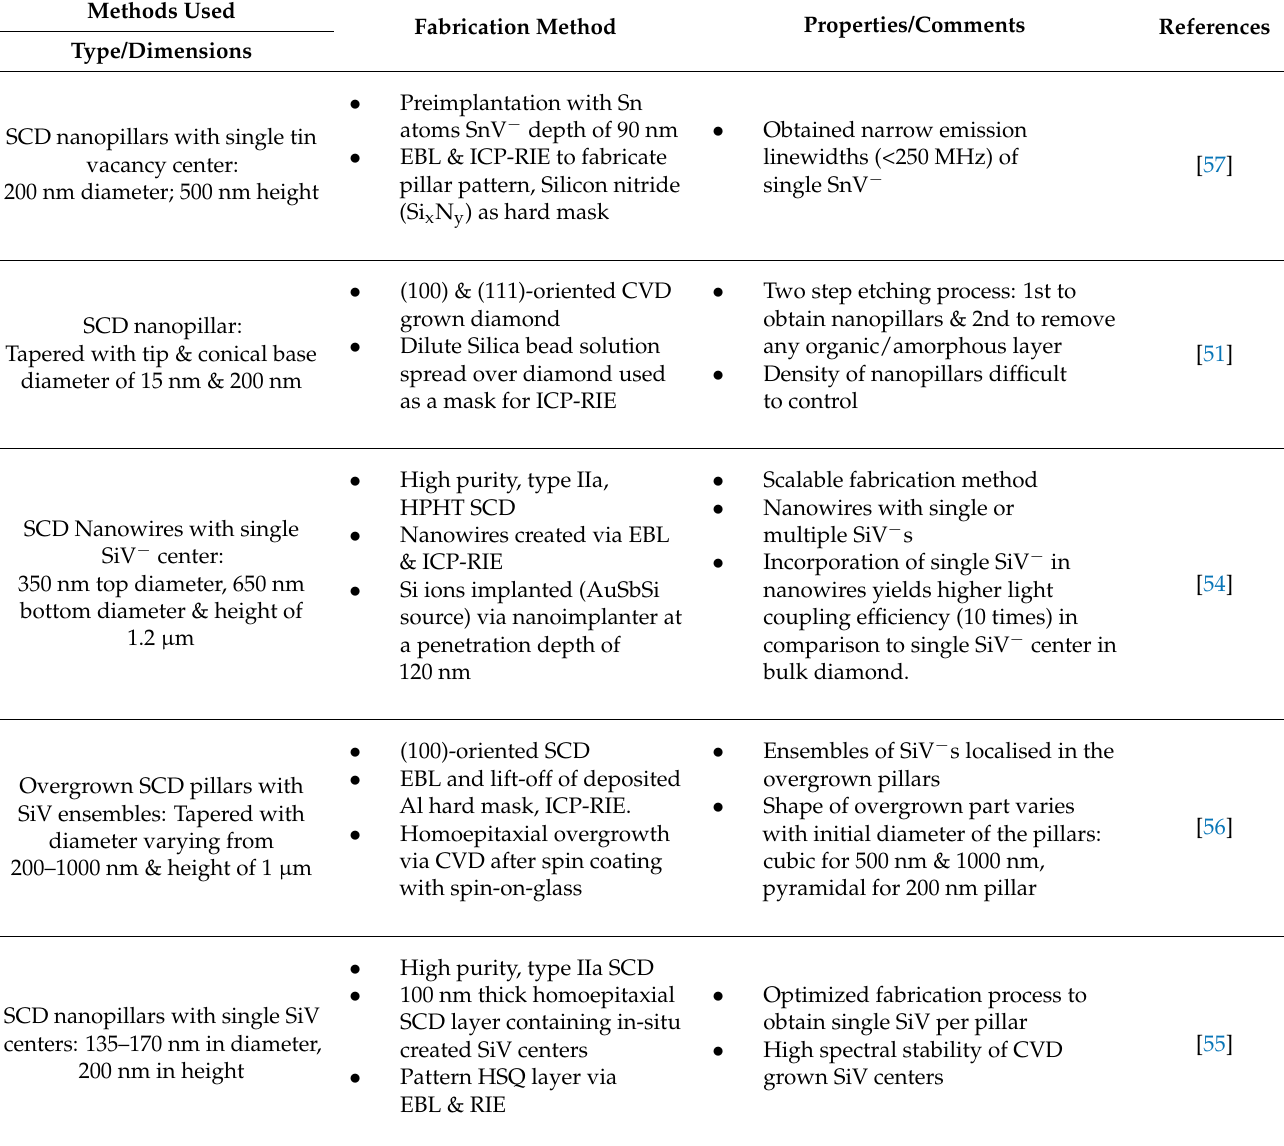
Table 1. Short description of different fabrication methods developed for nanowire/nanopillar